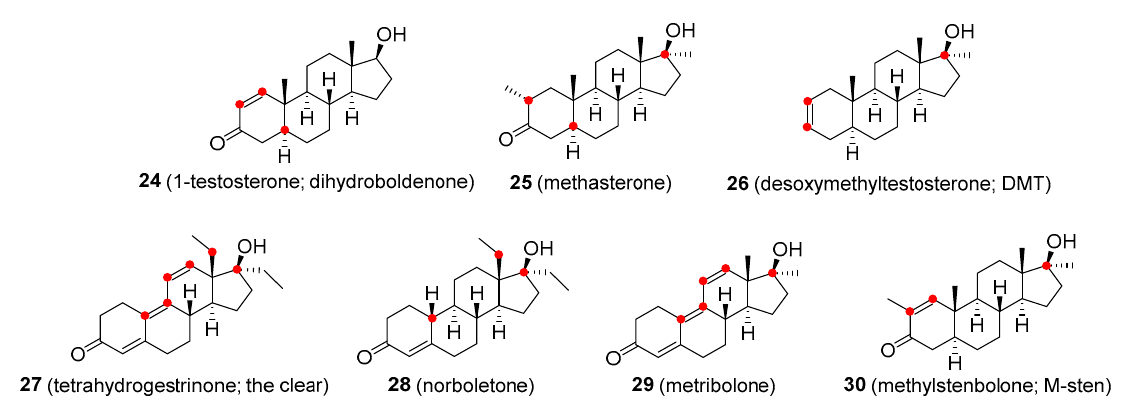
Figure 6. Designer drugs based on testosterone structure/functionalities.